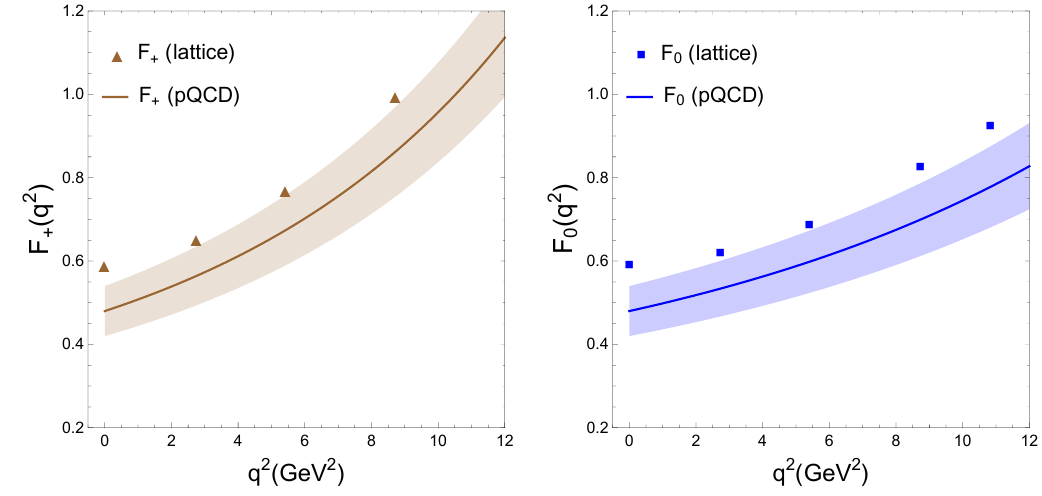
Figure 7 . Form factors F 0 ( q 2 ) B c ! (cid:17) c and F + ( q 2 ) B c ! (cid:17) c from pQCD [16] and lattice